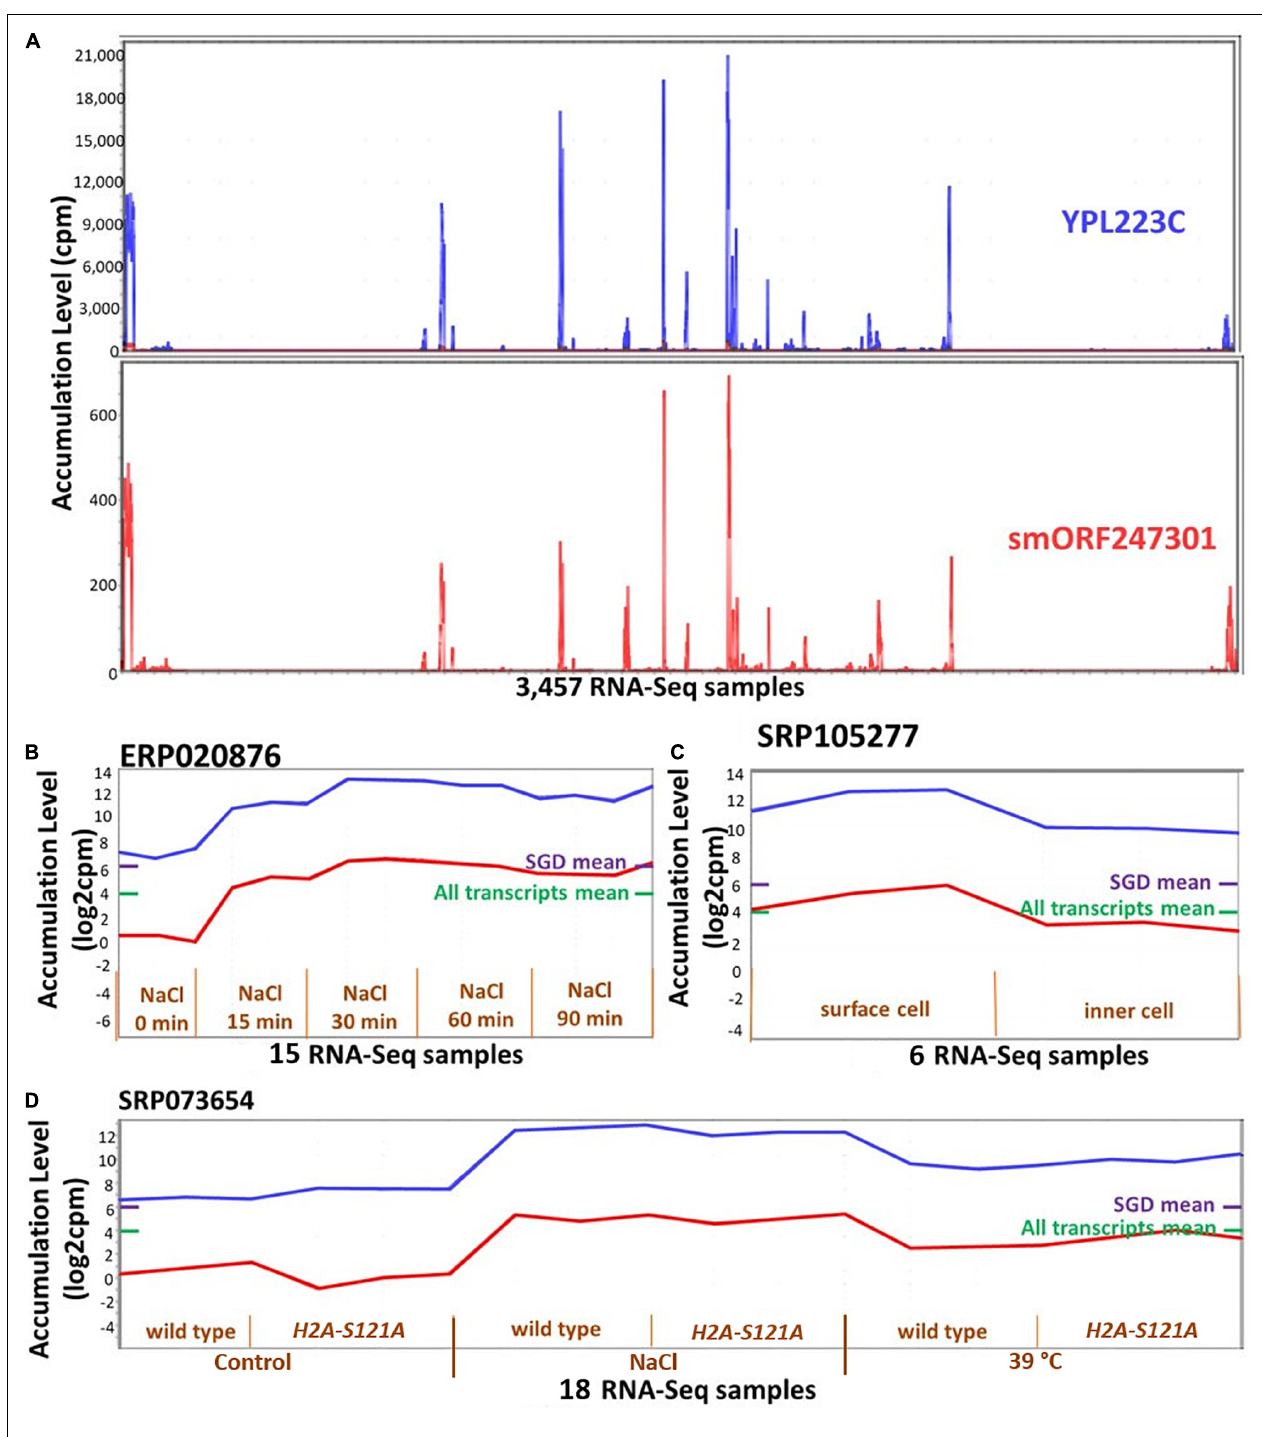
FIGURE 6 | Expression patterns of smORF247301 and YPL223C. smORF247301 and YPL223C are located on adjacent regions of chromosome 16 and are transcribed in convergent orientation. (A) Expression patterns are similar (Pearson correlation, 0.95) across 3,457 samples. (B–D) Expression patterns for smORF247301 and YPL223C in three studies. X -axis, 3 samples per treatment. Purple bar on right side of panels, mean expression level of all annotated genes; Green bar on right side of panels, mean expression level of all annotated genes and all ORFs. (B) Expression in response to osmotic stress; (C) expression in response to desiccation stress (surface cell under stress); (D) expression in response to osmotic and high temperature stress (wild strain vs H2A-S121A mutant). Visualizations and co-expression calculations used MetaOmGraph (MOG) (Singh et al., 2020).